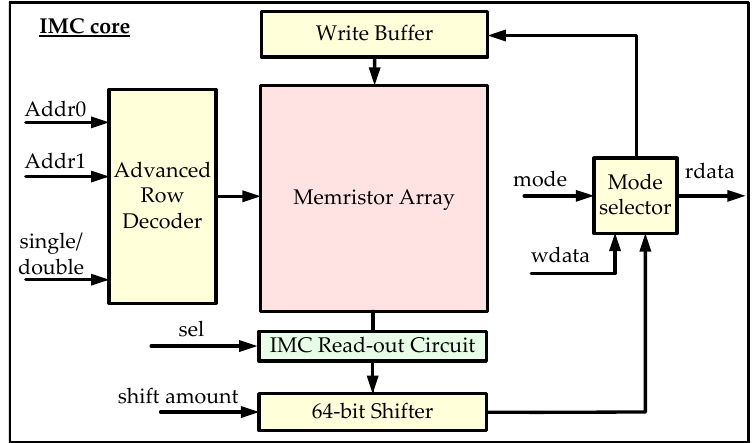
Figure 3. IMC core architecture.